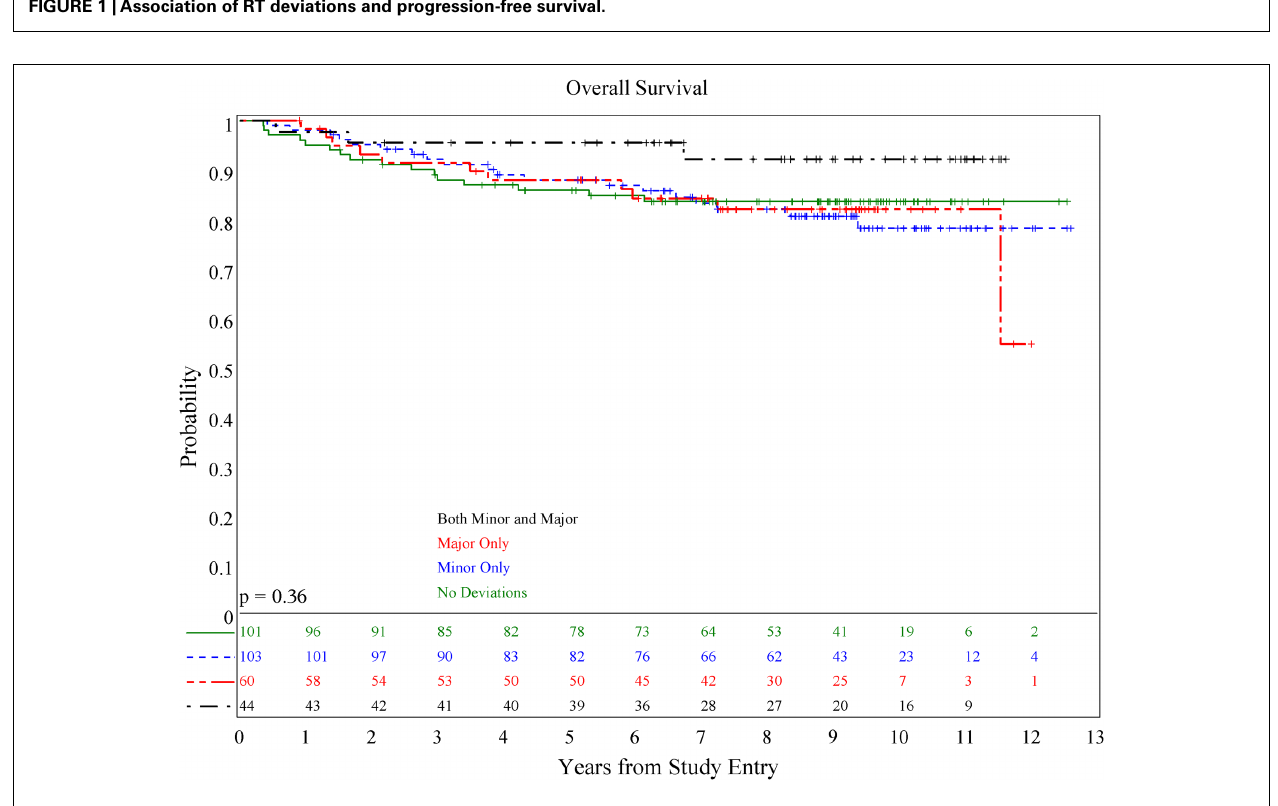
FIGURE 2 |Association of RT deviations and overall survival.